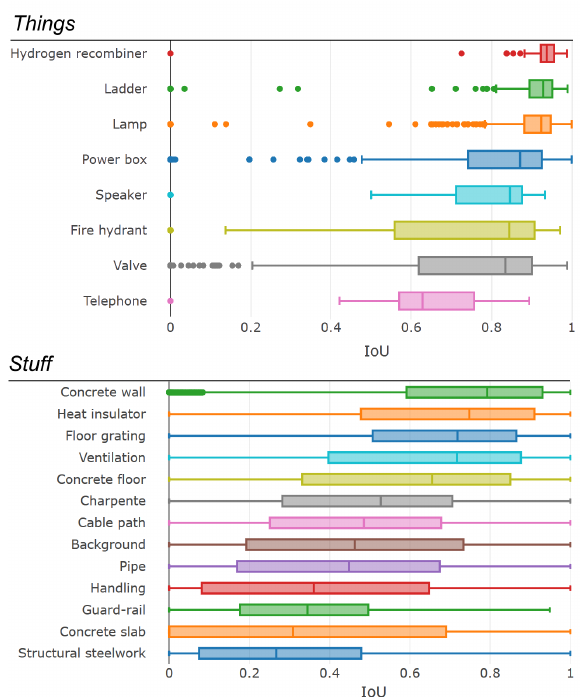
Figure 8. IoU results on the validation dataset (30 % of images). Top: things objects. Bottom: stuff objects